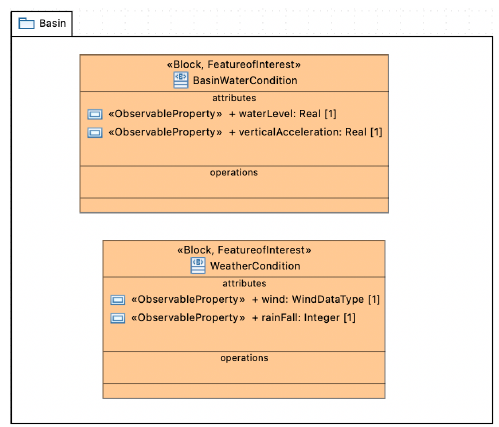
Figure 14. Basin Package: WMS Features of